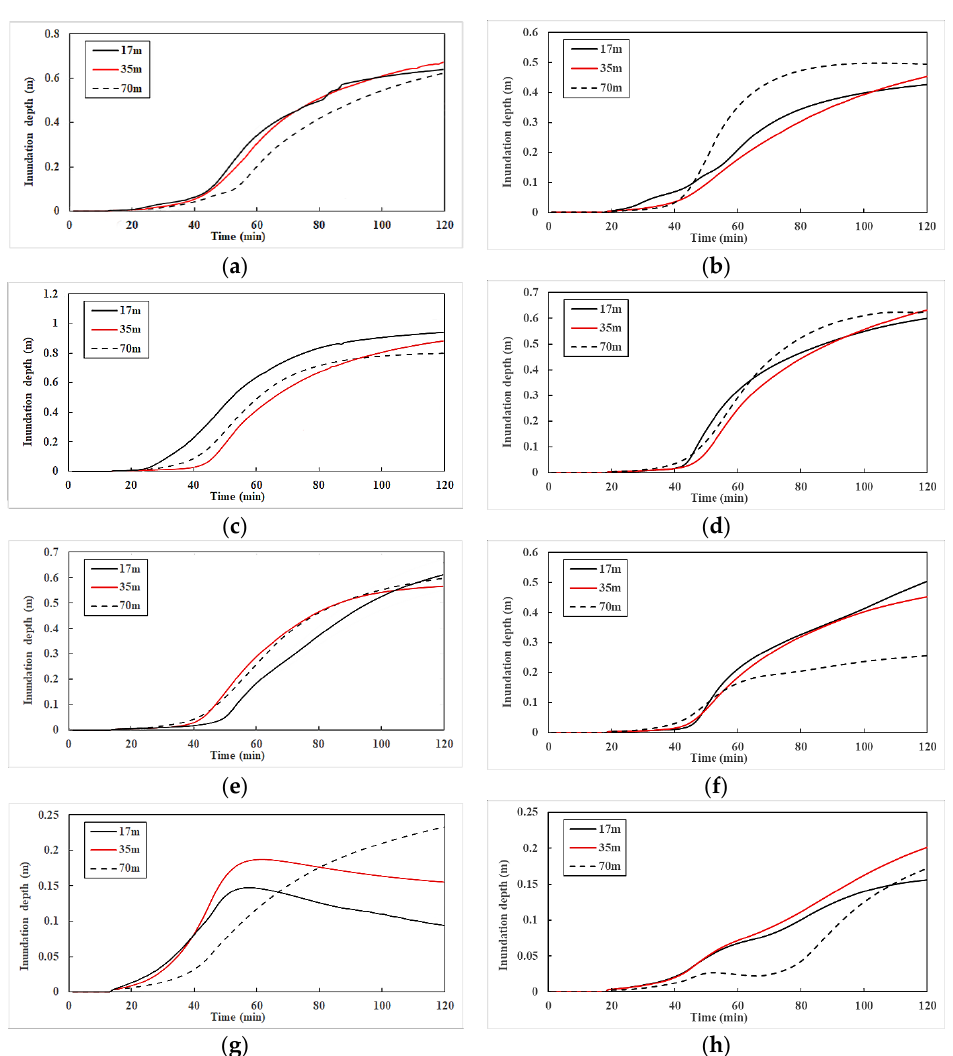
Figure 9. The inundation depth as a function of time for the three terrain resolutions (17, 35, and 70 m) at four observation points: ( a , c , e , g ) 10-year return period; ( b , d , f , h ) 2-year return period.